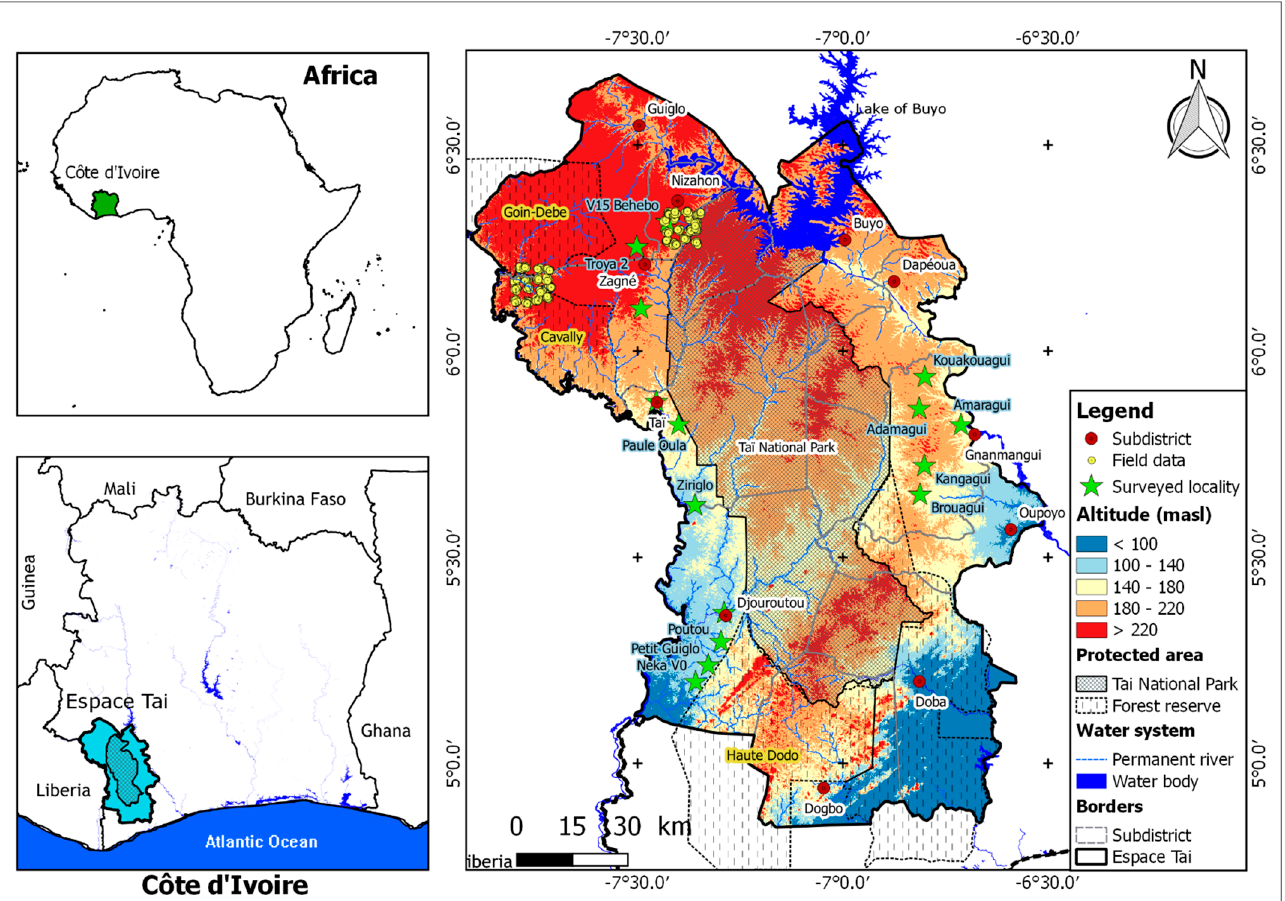
Figure 1. Map of the study area showing surveyed localities in south-western C ô te d’Ivoire. Administratively, the Espace Taï stretches over 11 sub-districts of three regions (Nawa, Cavally and San-Pedro). This region, covering about 17,334 km 2 in south-western C ô te d’Ivoire, is home to 842,640 inhabitants regrouped in 150,583 households according to the 2014 General Census of Population and Housing